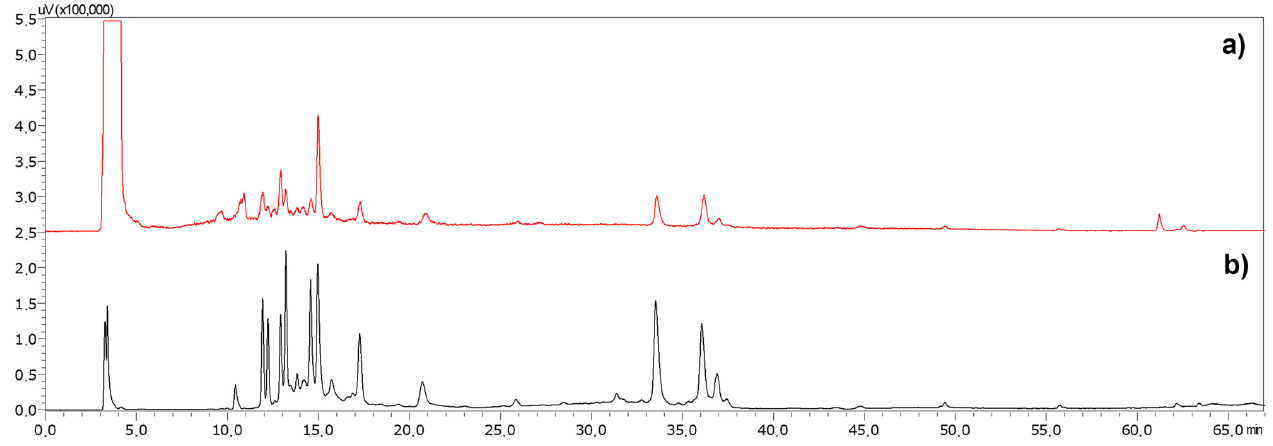
Figure 1. HPLC-ELSD profile of Rosa canina concentrated bud macerate before ( a ) and after ( b ) solid phase extraction (SPE).